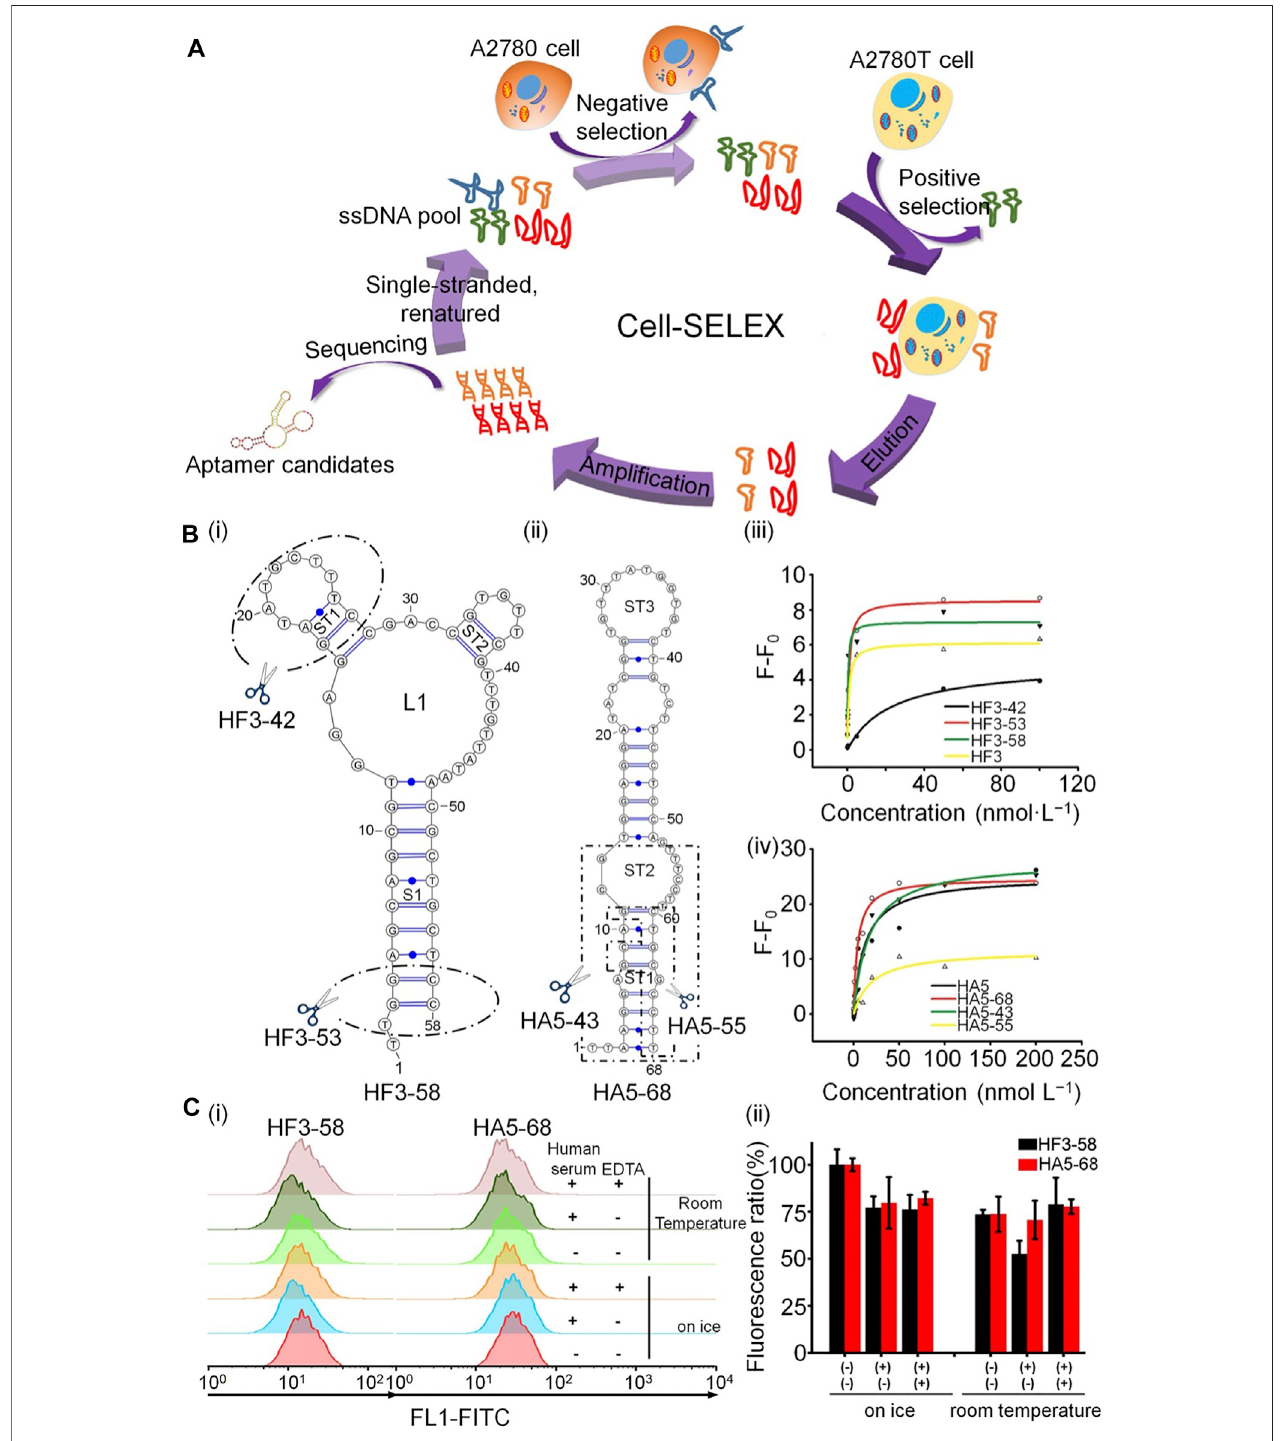
FIGURE 2 | Schematic illustration of aptamer recognition of drug-resistant cells. (A) Generation of aptamers targeting A2780T cells by cell-SELEX. (B) Structure prediction and structural optimization of aptamers: (i) HF3 − 58 and (ii) HA5 − 68. (iii,iv) Binding curves of aptamers to A2780T cells. (C) Binding capacity of HF3 − 58 and HA5-68 to A2780T cells.